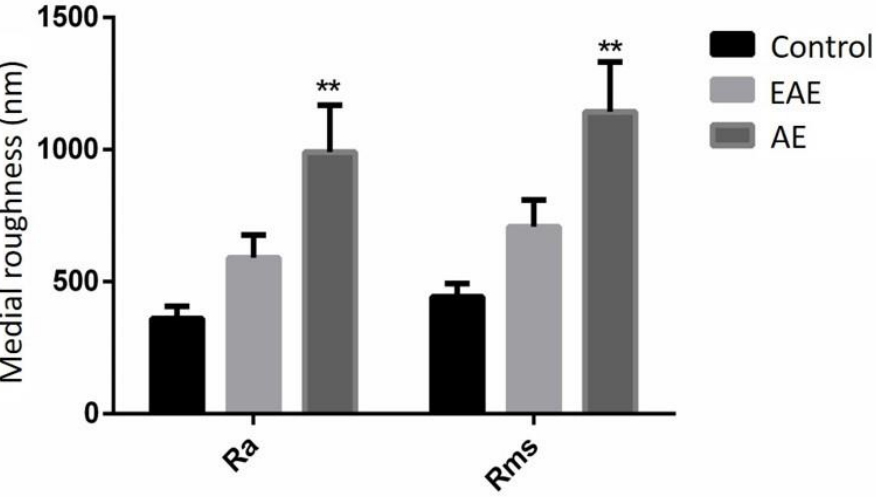
Figure 6. Median roughness tegument of S. mansoni treated with EAE and AE by AFM technique. ** p < 0.05 in relation to control group (untreated).